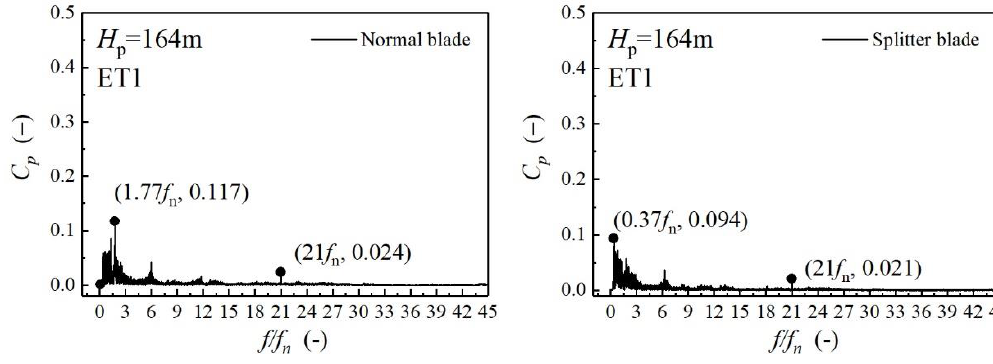
Figure 21. Frequency characteristics in cone of draft tube at 164 m head.